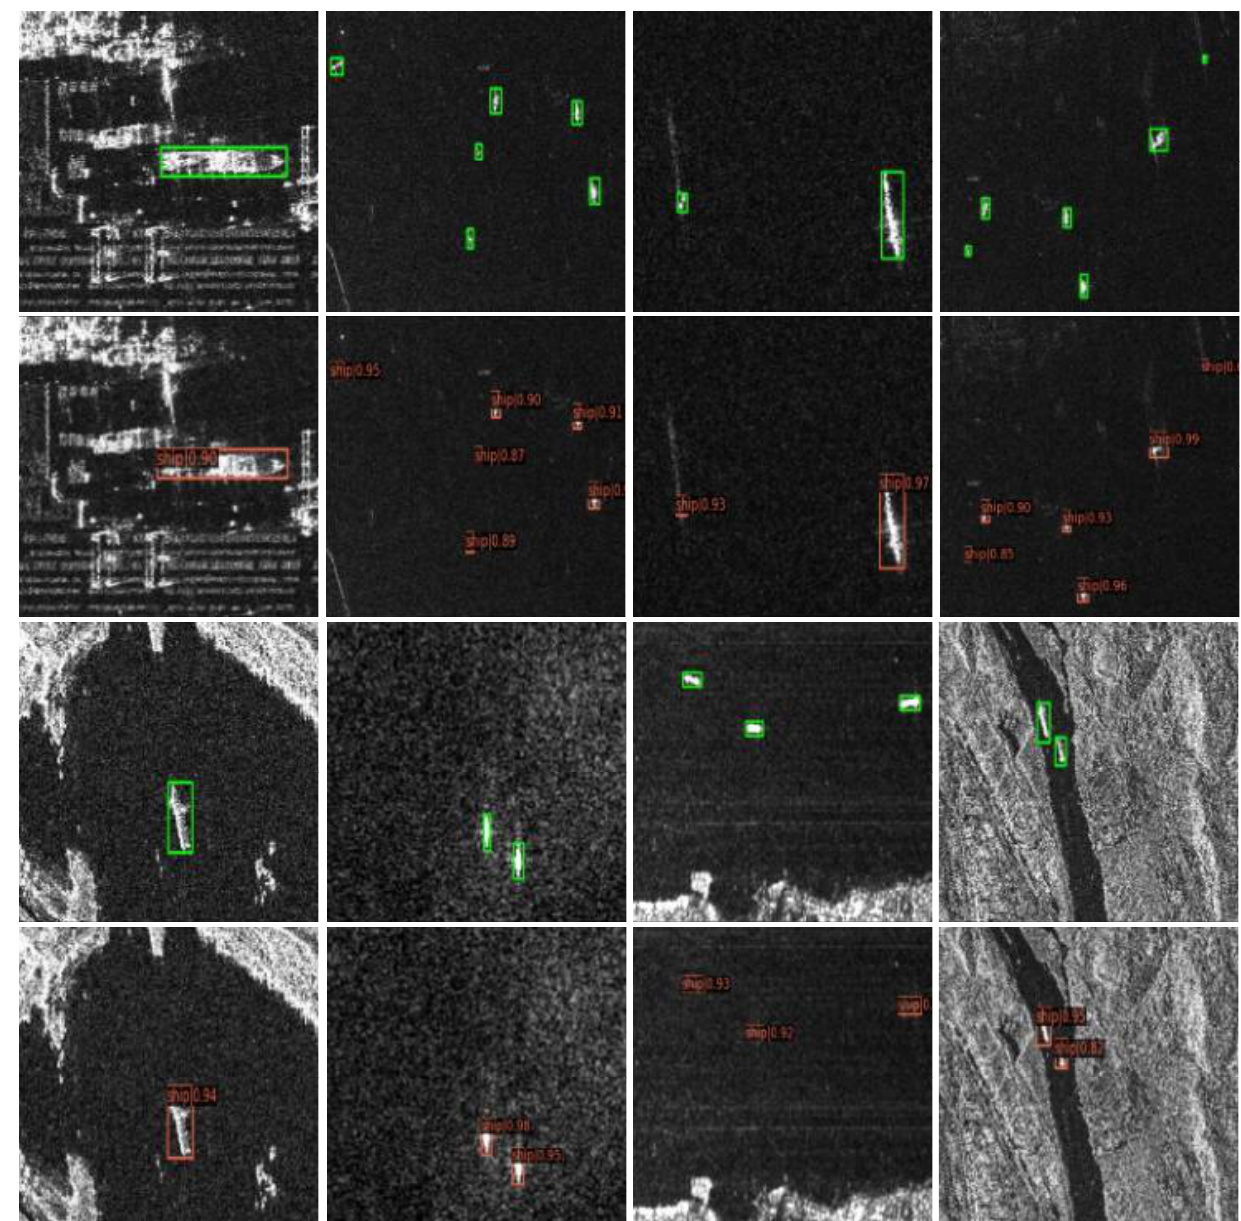
Figure 10. Visual results of the proposed method on SSDD. The green rectangles indicate the ground-truth, and the red rectangles indicate the detection results.